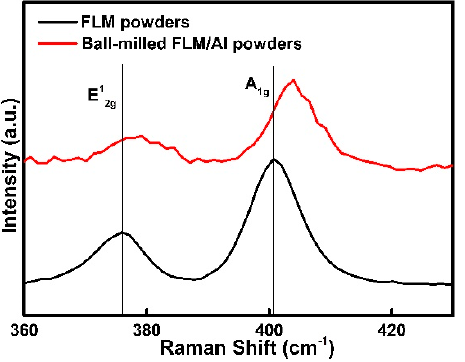
Figure 4. Raman spectra of raw MoS 2 nanosheets and composite powders after the ball-milling pro- cess.